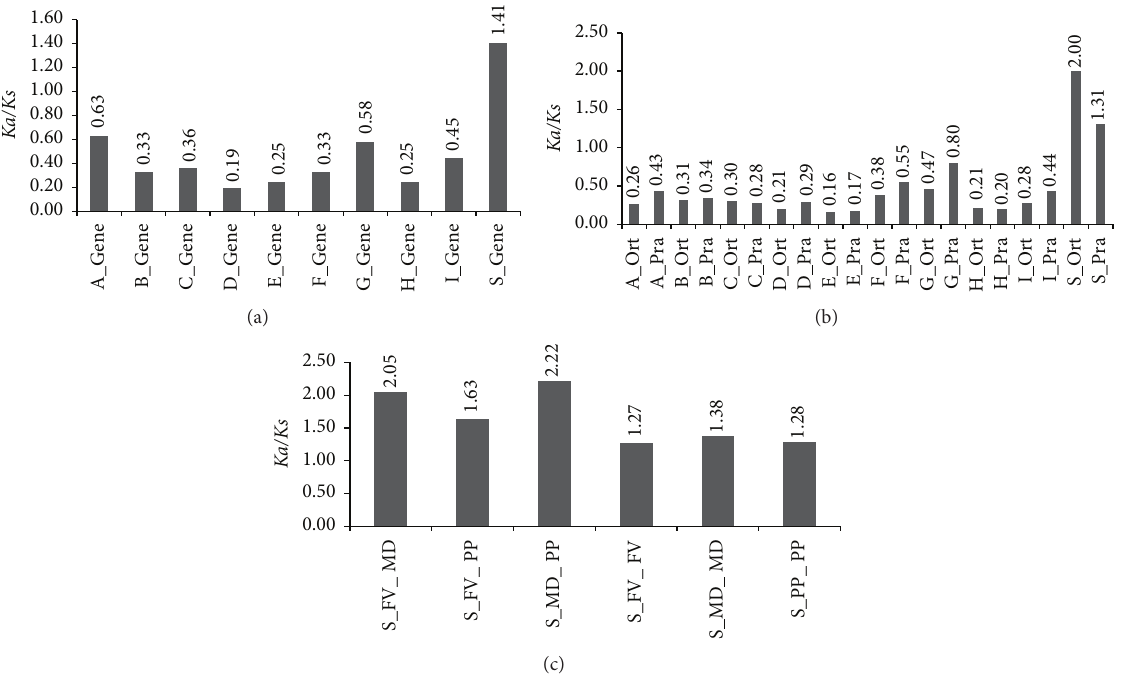
Figure 3: Ka/Ks ratios of bZIP genes. (a) Ka/Ks ratios of genes in clades A–S. (b) Ka/Ks ratios of paralogous and orthologous gene pairs in clades A–S. (c) Ka/Ks ratios of paralogs (FV FV, MD MD, and PP PP) and orthologs (FV MD, FV PP, and MD PP) in clade S. The Ka/Ks ratios are located in the top of the